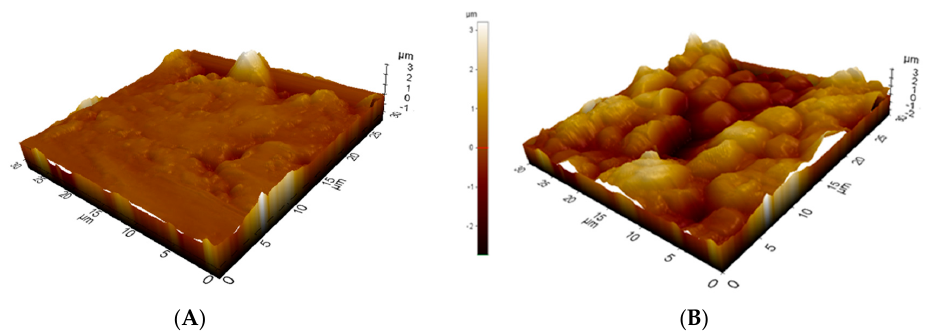
Figure 9. Three-dimensional view from AFM imaging of dried rattan pieces ( A ) and rattan with Figure 9. Three‑dimensional view from AFM imaging of dried rattan pieces ( A ) and rattan with immobilized cells after repeated-batch fermentation in System Ⅱ ( B ). immobilized cells after repeated‑batch fermentation in System II ( B Repeated-batch ethanol fermentation processes using immobilized S. cerevisiae from various substrates under high gravity (HG) and very high gravity (VHG) conditions are compared in Table 3. Many agricultural materials, including rattan, have been successfully used as carriers for cell immobilization. Sweet sorghum stem juice gave an ethanol yield (0.48 g/g) as high as that using glucose as a substrate. Differences in ethanol production in terms of P E , Q P , SC , and Y P/S are mainly due to the variations in substrate, yeast species and operating conditions. Table 3. Repeated-batch ethanol fermentation with immobilized S. cerevisiae on various carriers. Substrate Initial Sugar (g/L)